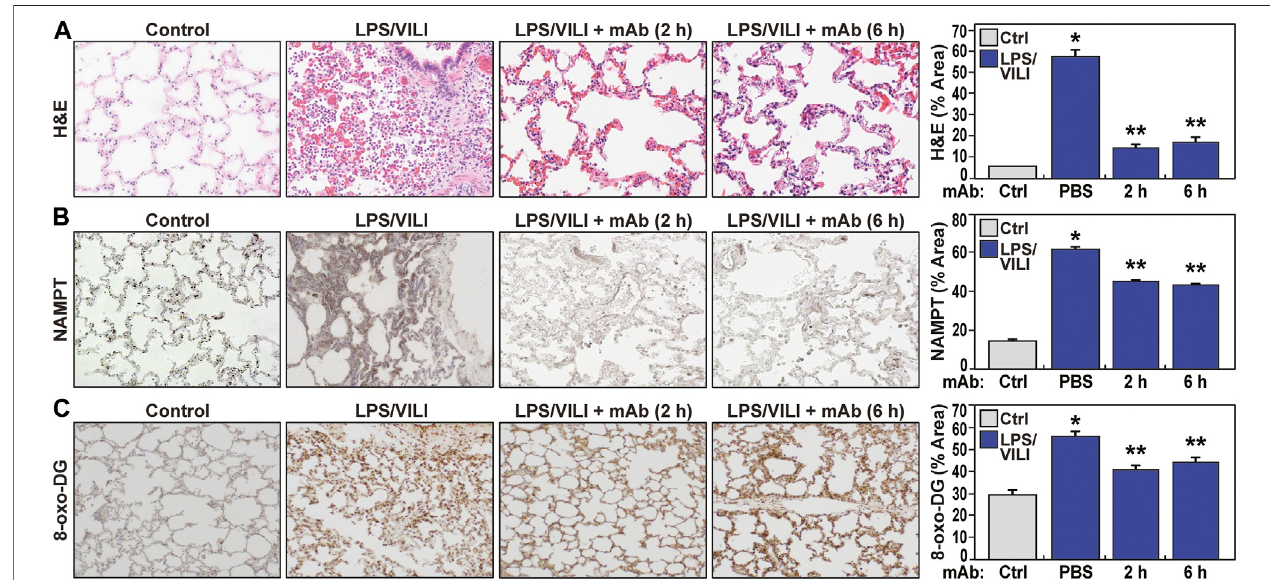
FIGURE 1 | The eNAMPT ALT-100 mAb attenuates in fl ammatory lung injury in the LPS/VILI porcine model. (A) Representative H&E staining of lung tissues from Yucatan male minipigs (17 – 20 kg, n = 4/group) exposed to intratracheal LPS-induced pneumonia and IV LPS-induced septic shock accompanied by VILI for 12 h. Compared to control animals, LPS/VILI-exposed minipigs receiving IV PBS at 2 h exhibited dramatic histologic evidence of severe in fl ammatory lung injury with signi fi cant alveolar in fl ammation, neutrophil in fi ltration and alveolar edema quanti fi ed by Image J. The administration of IV ALT-100 eNAMPT mAb (0.4 mg/kg), delivered either 2 h or 6 h after the start of LPS/VILI injury, resulted in signi fi cantly reduced lung in fl ammation quanti fi ed by ImageJ (* p < 0.01 vs. control; ** p < 0.01 vs. PBS). Magni fi cation scale bar represents 50 uM. (B) Representative prominent increases in NAMPT lung tissue staining in LPS/VILI-exposed pigs detected by IHC staining. LPS/VILI-exposed minipigs receiving ALT-100 mAb intravenously at 2 h or 6 h exhibited signi fi cantly reduced NAMPT staining. (C) Similar to Panel B, representative 8-oxo-DG staining of lung tissues from LPS/VILI-exposed pigs showed prominent increases in 8-oxo-DG staining re fl ecting marked increases in reactive oxygen species (ROS) generation. LPS/VILI-exposed minipigs receiving IV ALT-100 mAb at 2 h or 6 h exhibited signi fi cantly reduced 8-oxo-DG staining. * p < 0.05 control vs. untreated LPS/VILI; ** p < 0.05 mAb LPS/VILI vs. untreated LPS/VILI. There were no signi fi cant differences in imaging responses between animals receiving ALT-100 mAb at 2 vs. 6